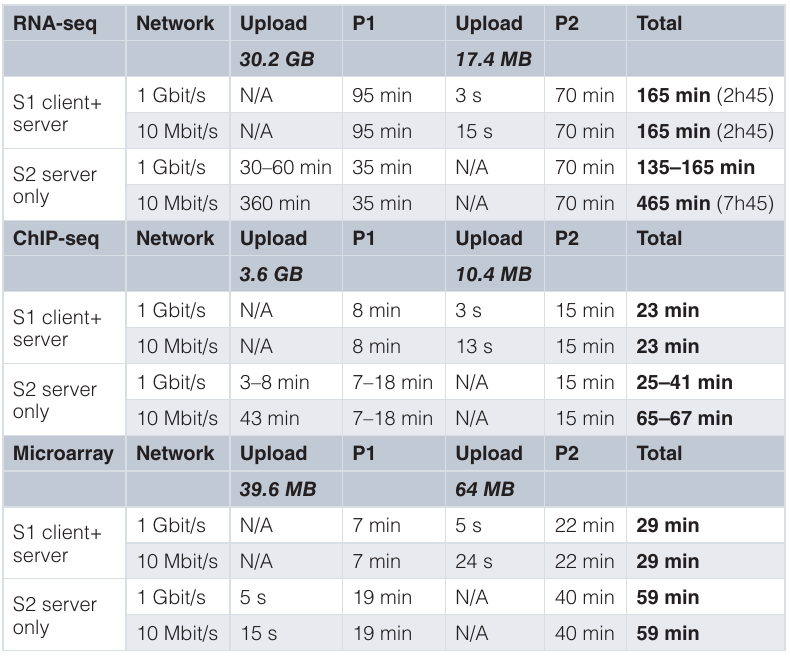
Table 1. Performance results using ISMARA client with three different input datasets. The analysis used a client with 4 cores and a server with 12 cores, on both fast and slow networks. Tests were done in July